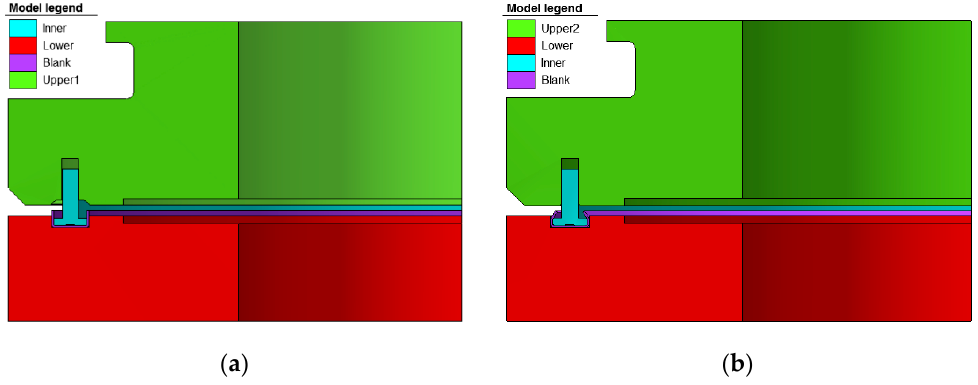
Figure 7. Finite element model of multi-pass stamping of concave ring. ( a ) First pass; ( b ) Second pass.